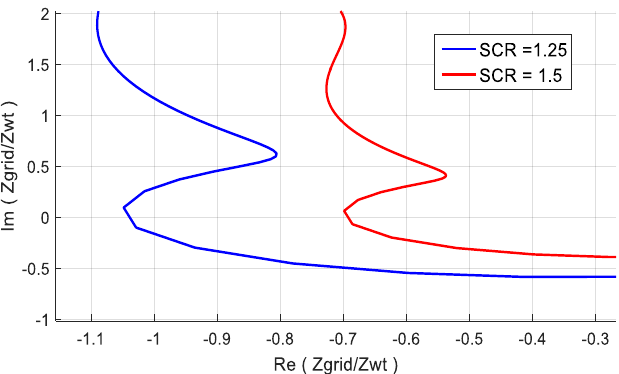
Figure 9. Nyquist criteria under SCR variations for X g / R = 20 and X c / X g = 0.